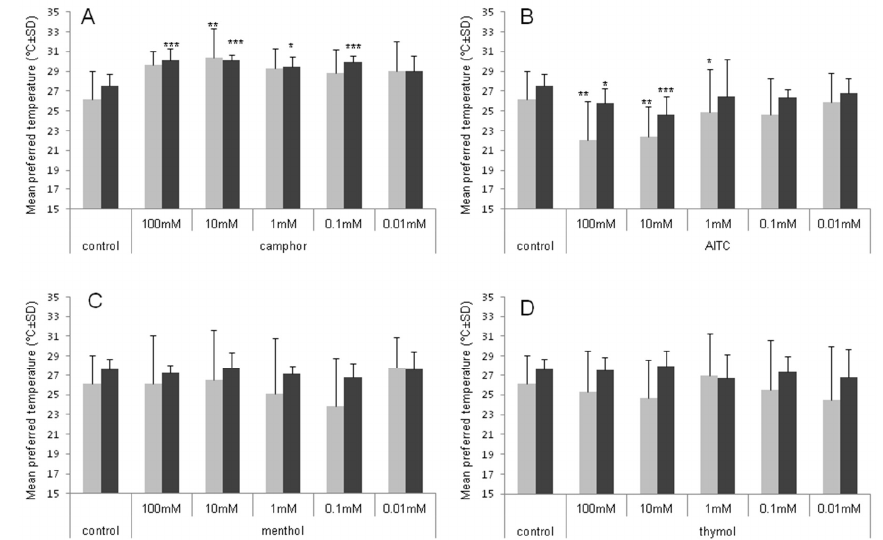
Figure 1. Thermal preference of the American cockroaches exposed to TRP ligands: Camphor ( A ), AITC ( B ), menthol ( C ) and thymol ( D ). Data are presented as the mean preferred temperature from the first 30 min (grey column) and from 1–23 h (black column) after exposure. Statistically significant differences in comparison to the control group are indicated as: * p < 0.05; ** p < 0.01; *** p < 0.001 (one-way analysis of variance (ANOVA) on ranks; n = 12).